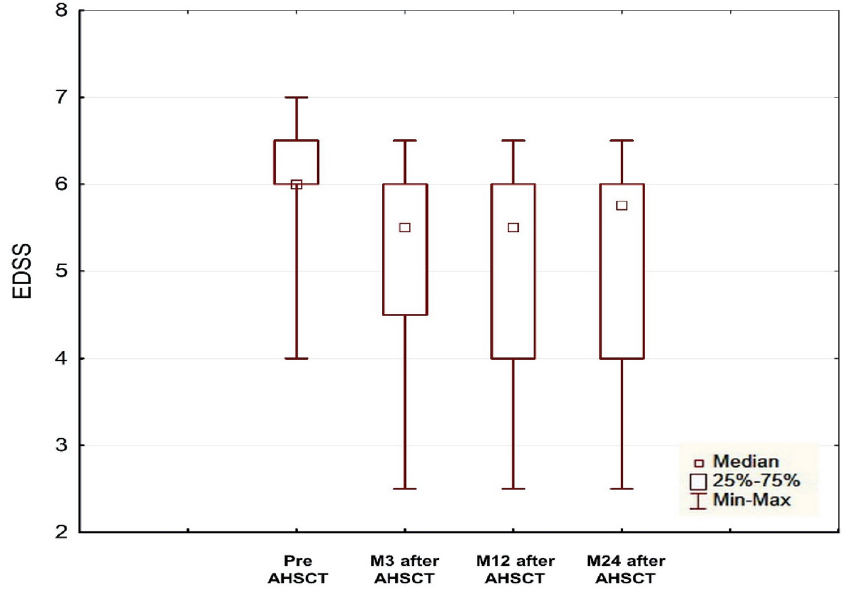
Figure 1. Changes in EDSS score from baseline to Month24 after AHSCT. EDSS Expanded Disability Status Scale, AHSCT autologous hematopoietic stem cell transplantation, preAHSCT before autologous hematopoietic stem cell transplantation, M3 month 3, M12 month 12, M24 month 24.